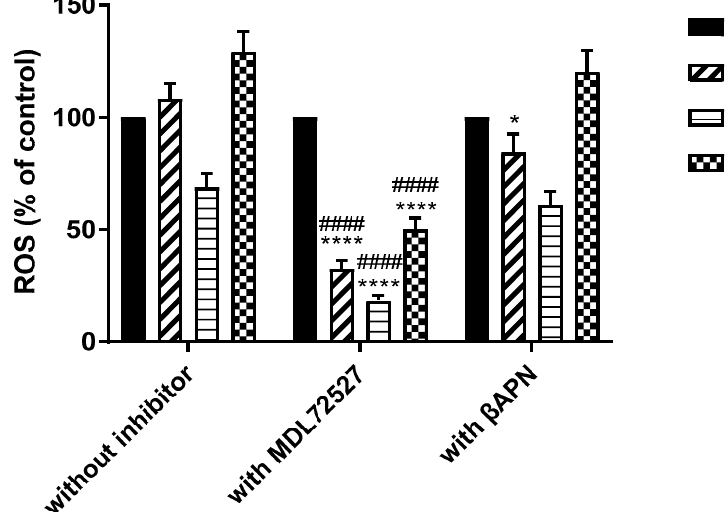
hash ( # ) indicates statistical difference in ROS production detected between treatments at each respective time point. Values are mean ± S.E.M. (n = 5).